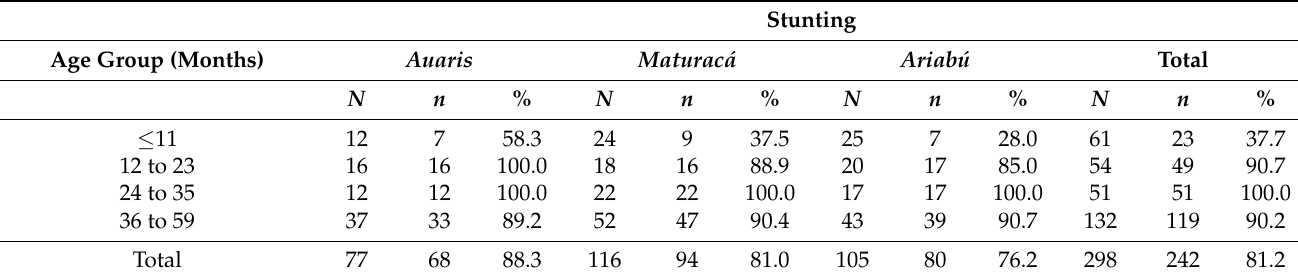
Table 1. Stunting characterization in children under 5 years of age, according to the villages of residence. Yanomami Indigenous Territory, Brazilian Amazon, 2018–2019.